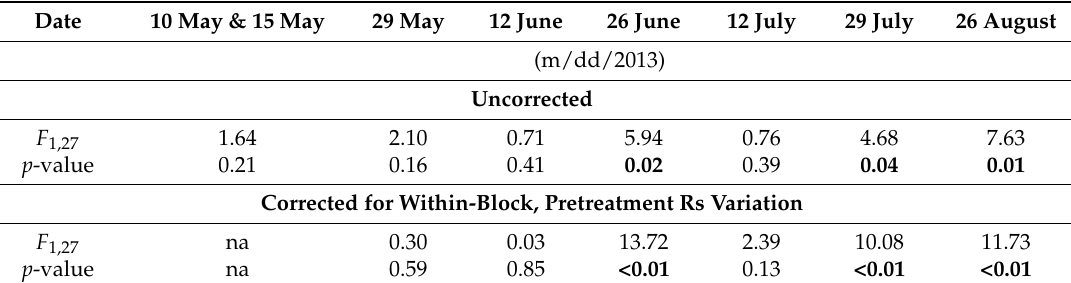
Table 3. Statistical summary of the influence of treatment on mean soil respiration (R s ) measurements by date in three 26-year-old longleaf pine ( Pinus palustris Mill.) stands. Summaries given for the comparison of R s from control collars versus R s from root exclusion tubes uncorrected and corrected for within-block, pretreatment R s variation. Bolded p -values are significant at α = 0.05.